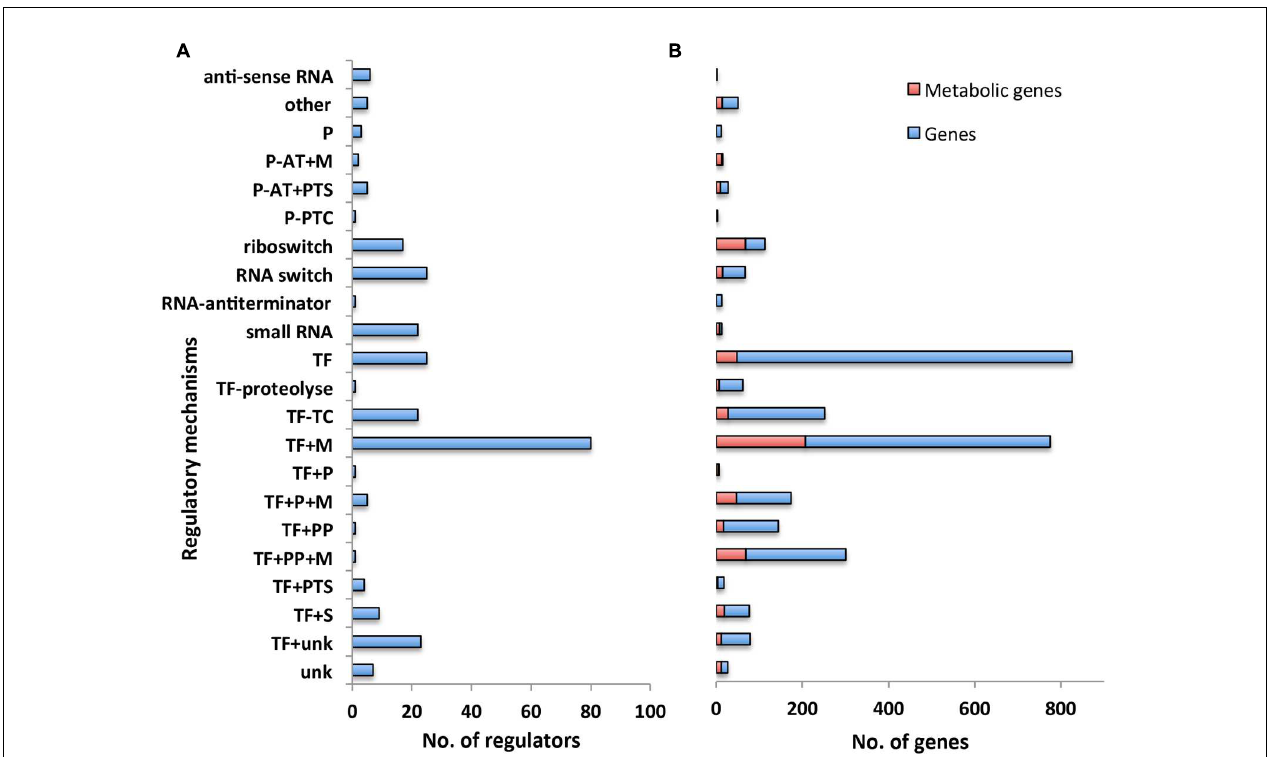
FIGURE 2 | Overview of regulatory network categorized by regulatory mechanism. (A) Number of regulators with respect to their regulatory mechanisms. Each bar corresponds to the number of regulators having the same type of regulatory mechanism. (B) Number of genes with respect to the regulatory mechanisms controlling their expression. Each bar refers to the number of genes that are controlled by a regulator having the same type of regulatory mechanism. Number of genes involved in the metabolism is highlighted in red. Abbreviations: P (Accessory protein involved in regulation); P-AT + M (Protein – transcriptional antiterminator conditioned by a metabolite); P-AT + PTS (Protein – transcriptional antiterminator conditioned by a PTS phosphorylation); P-PTC (Protein post-transcriptional control); TF (Transcription factor); TF–TC (Two-component response regulator); TF + M (Transcription factor conditioned by a metabolite); TF + P (Transcription factor + accessory protein); TF + P + M (Transcription factor + accessory protein associated to a metabolite); TF + PP (Transcription Factor + phosphorylated protein); TF + PP + M (Transcription factor + phosphorylated protein + metabolite); TF + PTS (Transcription factor + PTS phosphorylation); TF + S [Transcription factor + stress (DNA alteration/TF alteration)]; TF + unk (Transcription factor conditioned by an unknown